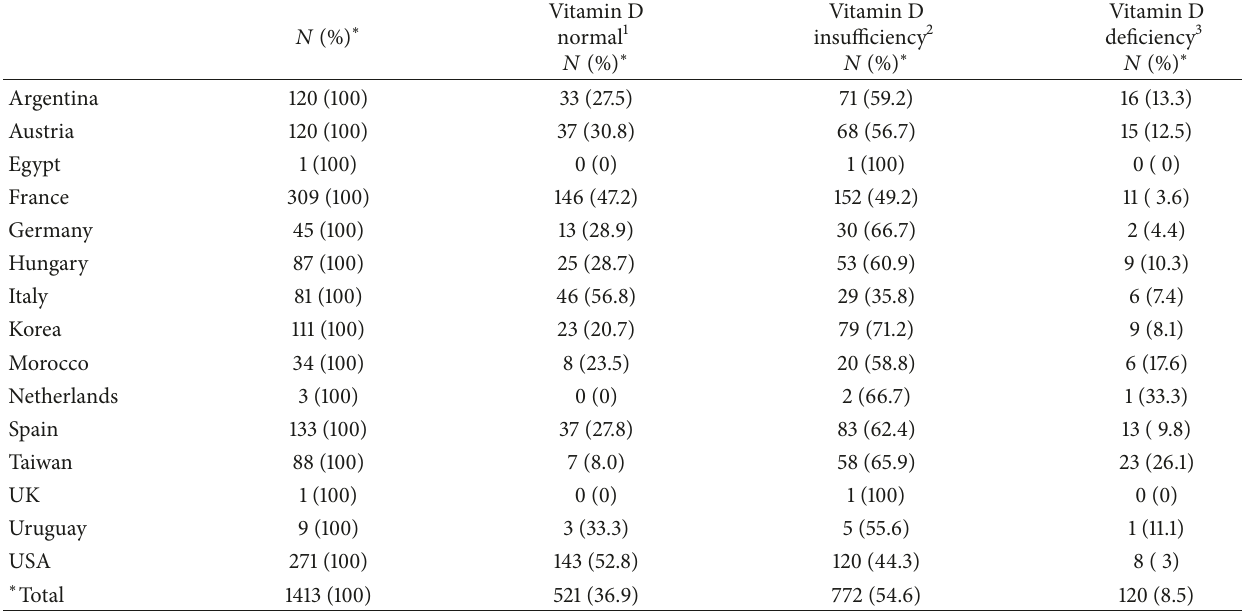
Table 2: Vitamin D status according to countries.